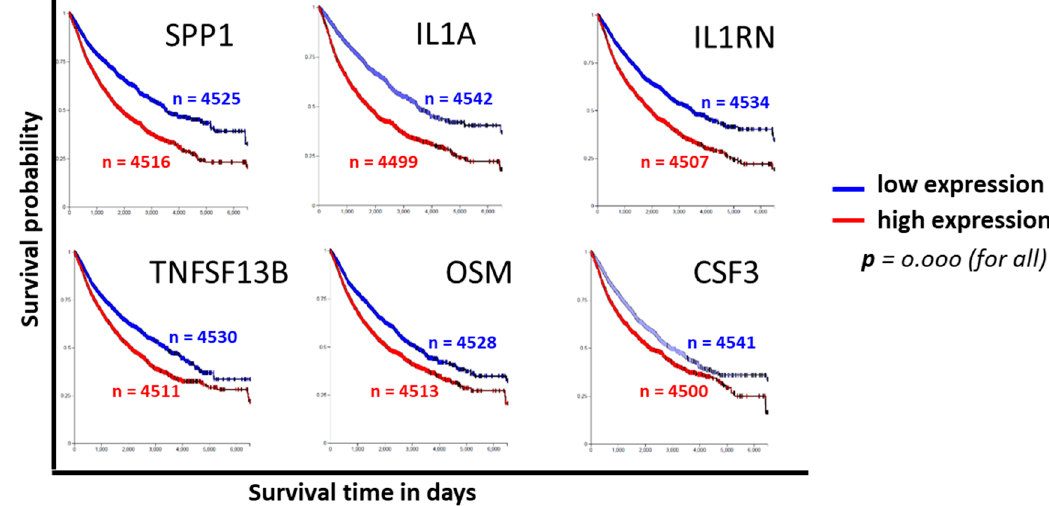
Figure 4. Cytokine genes identified as CPT-responsive were probed for clinical significance in the pan-cancer (PANCAN) TCGA database using the UCSD XenaBrowser platform. Kaplan–Meier patient survival curves for the top six genes with a highly significant ( p = 0.000) survival probability based on the level of gene expression are shown. n = number of patients in the survival curve computation.